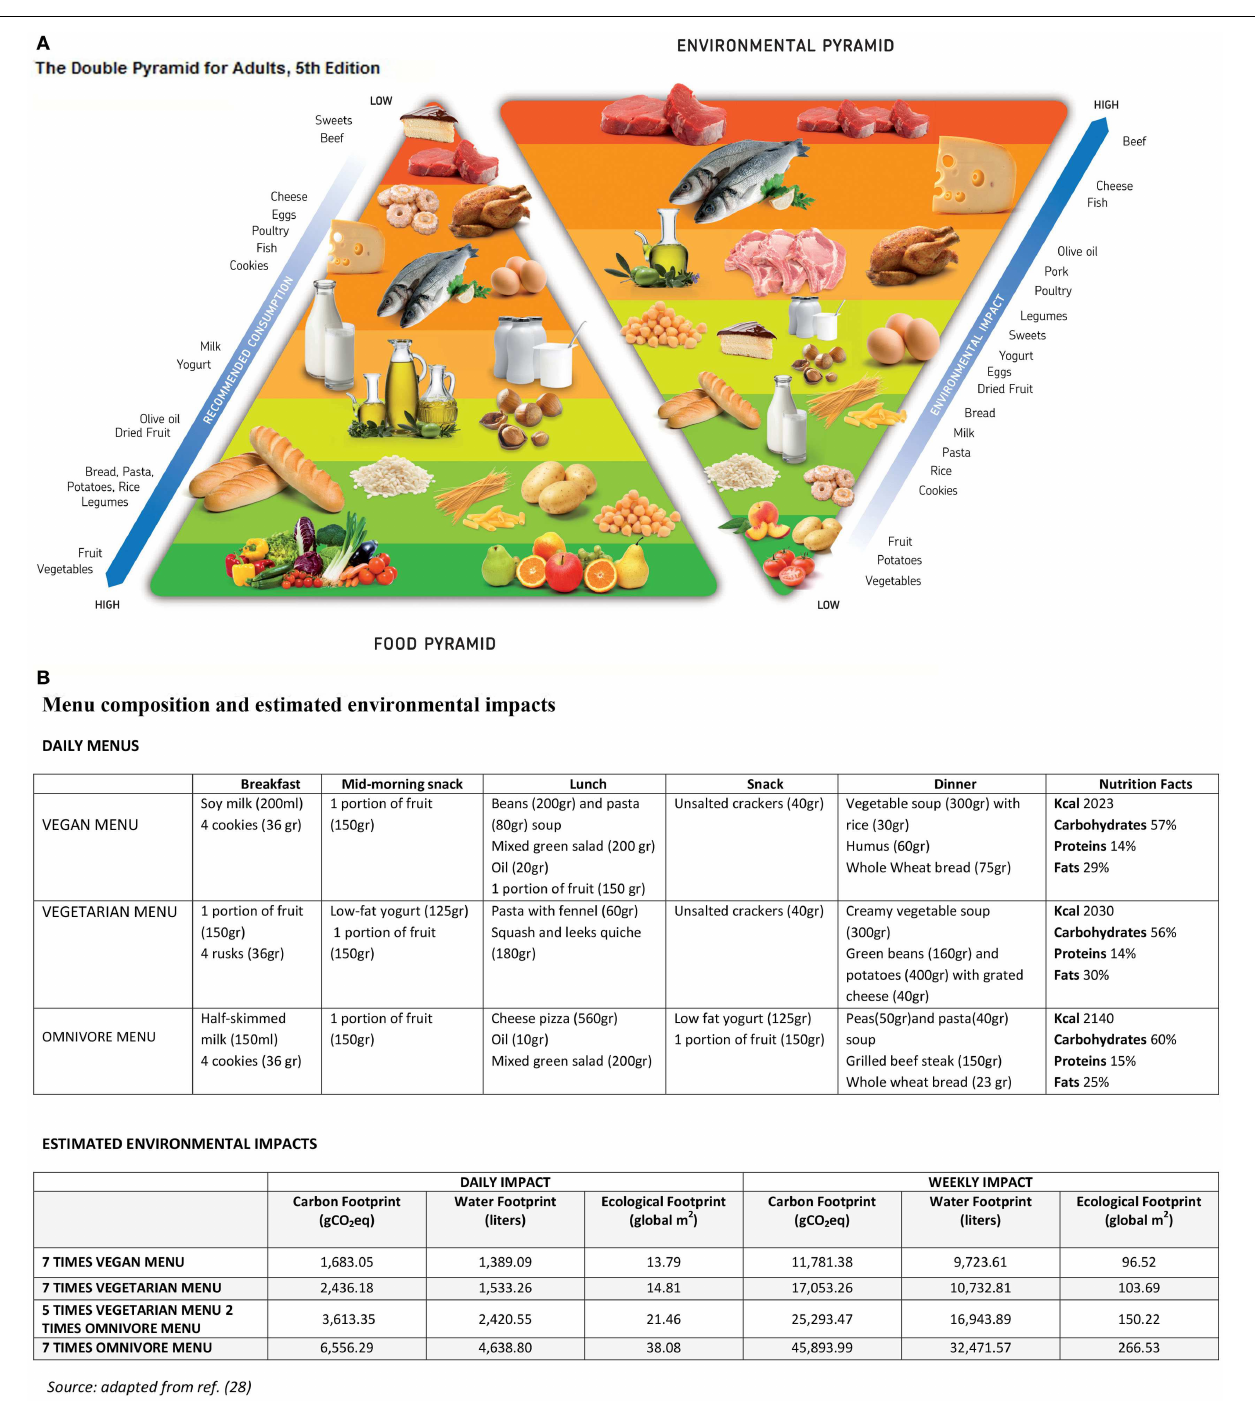
FIGURE 1 | (A) The double food and environment pyramid [Source: Ref. (28)]. (B) The environmental impact of different menus [Source: Ref. (28)].